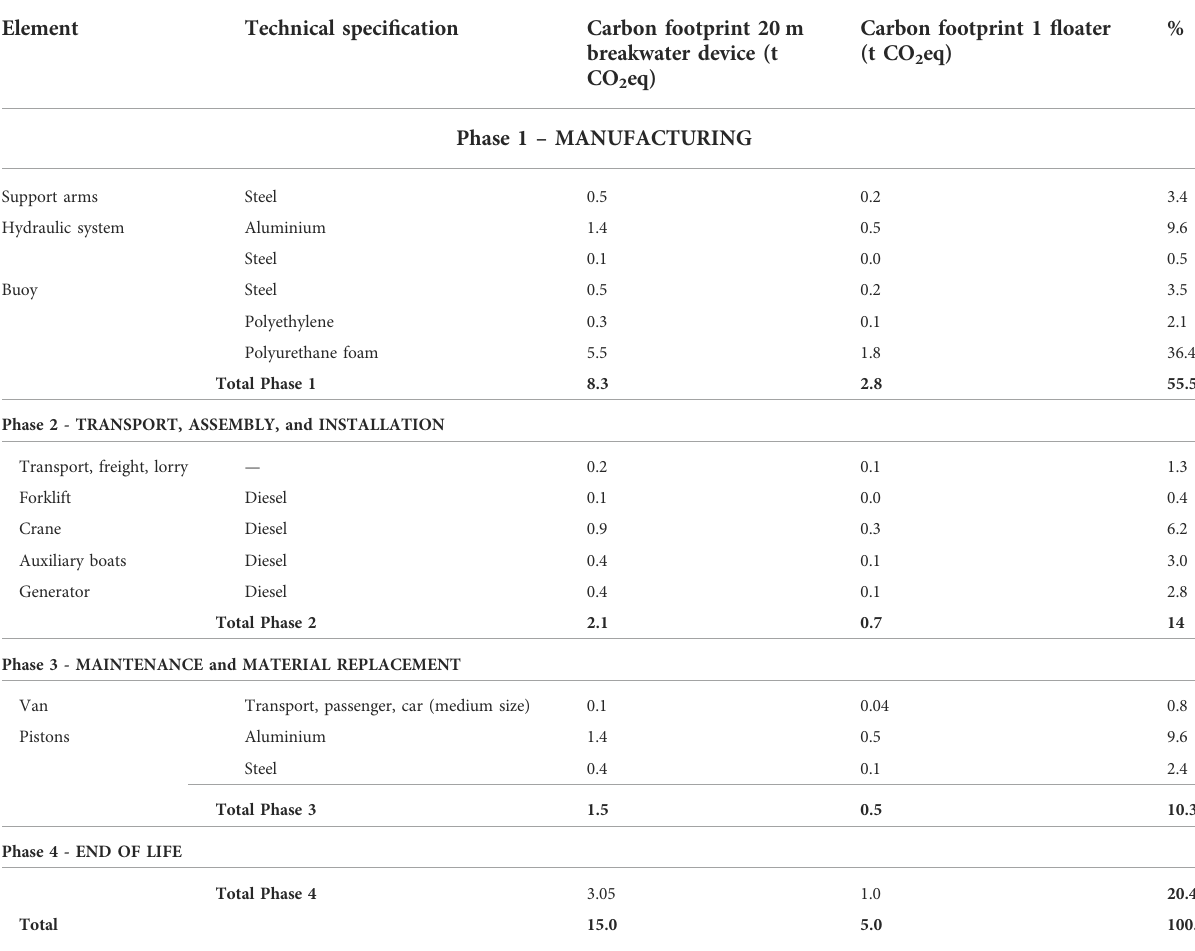
TABLE 6 Total GWP (t CO 2 eq) impact category results for the oscillating fl oater andvalues for individual components.Values in bold represent totals and subtotals.